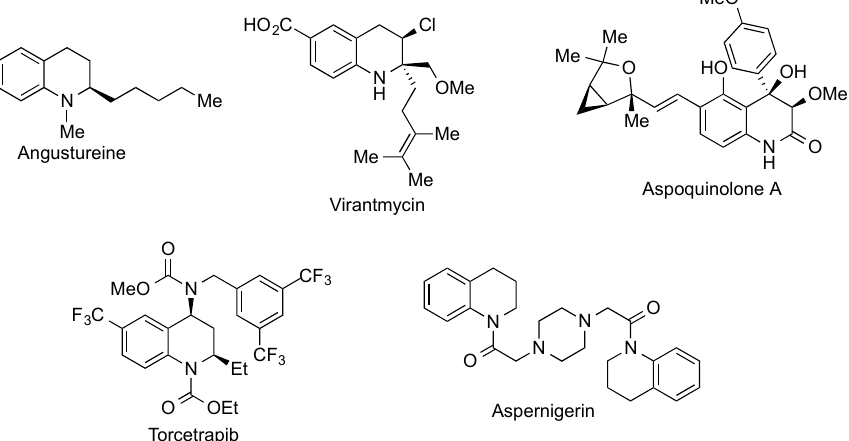
Figure 1. Structures of selected tetrahydroquinoline derivatives.